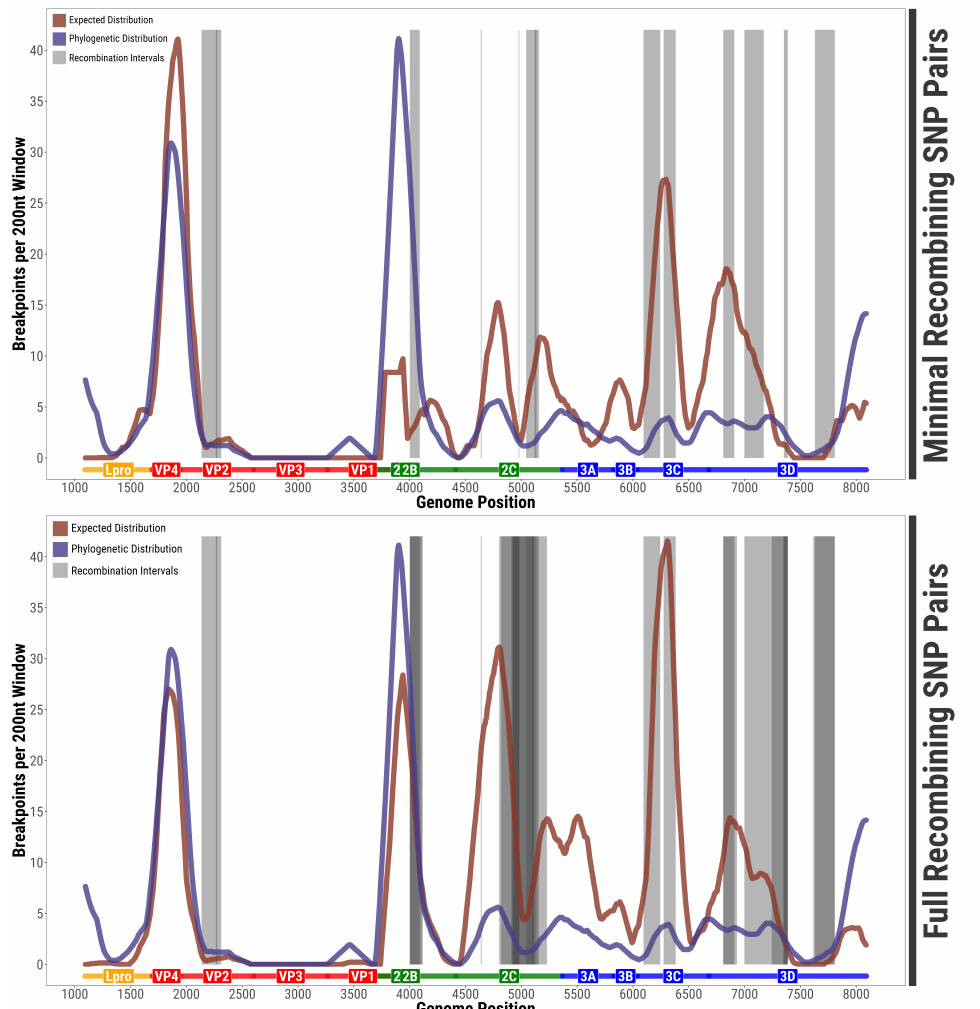
Figure 4. Comparison of within-host and phylogenetic recombination signal: ( Top ) Location of intervals between minimal recombining SNP pairs (grey) and expected distribution of recombination events corrected for the SNP distribution (red) along the FMDV genome. The expected distribution is based on the number of phylogenetic breakpoints inferred by RDP4 over a 200-bp window (blue) corrected for the probability of detecting a recombination events depending on the genomic location. ( Bottom ) Same plot for all recombining SNP pairs and the corresponding expected